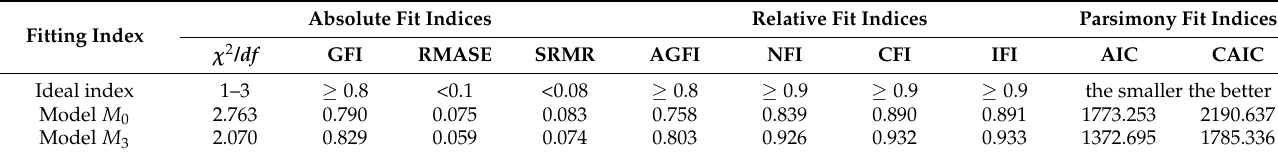
Table 7. Comparison of fit indices for model M 0 and M 3